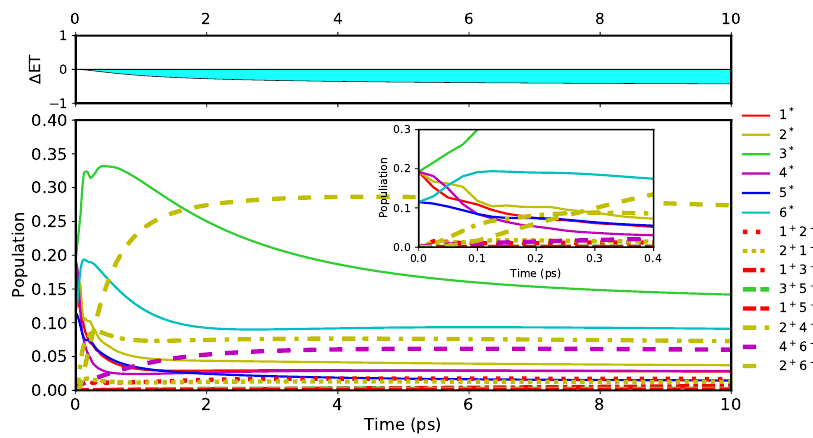
Figure 10. Population and ∆ ET dynamics of FE and CT states at 77 K. Out of the 36 states used for computations, only the selected 14 states are displayed for clarity. The level shifts are set to ∆ E 4 = − 3100cm − 1 , ∆ E 6 = − 5600cm − 1 , and ∆ E 2 = ∆ E 3 = ∆ E 5 = 0 to activate FEs → | 2 + 4 − (cid:105) → | 2 + 6 − (cid:105)